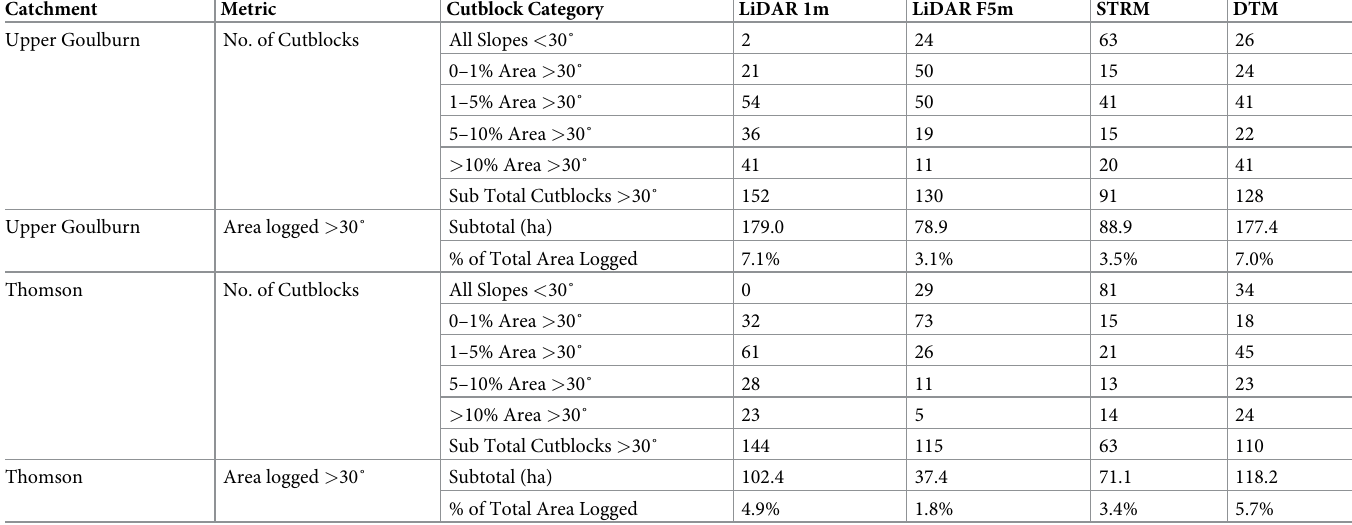
Table 1. Cutbblocks calculated with slopes > 30˚ logged across the Upper Goulburn and Thomson Catchments using LiDAR at 1 m resolution (LiDAR 1m), LiDAR with a 5m (LiDAR F5m) average slope neighbourhood, the Shuttle Topography Radar Mission (STRM) at a 1 arc second resolution and the VicMap Elevation DTM (DTM) at 10m